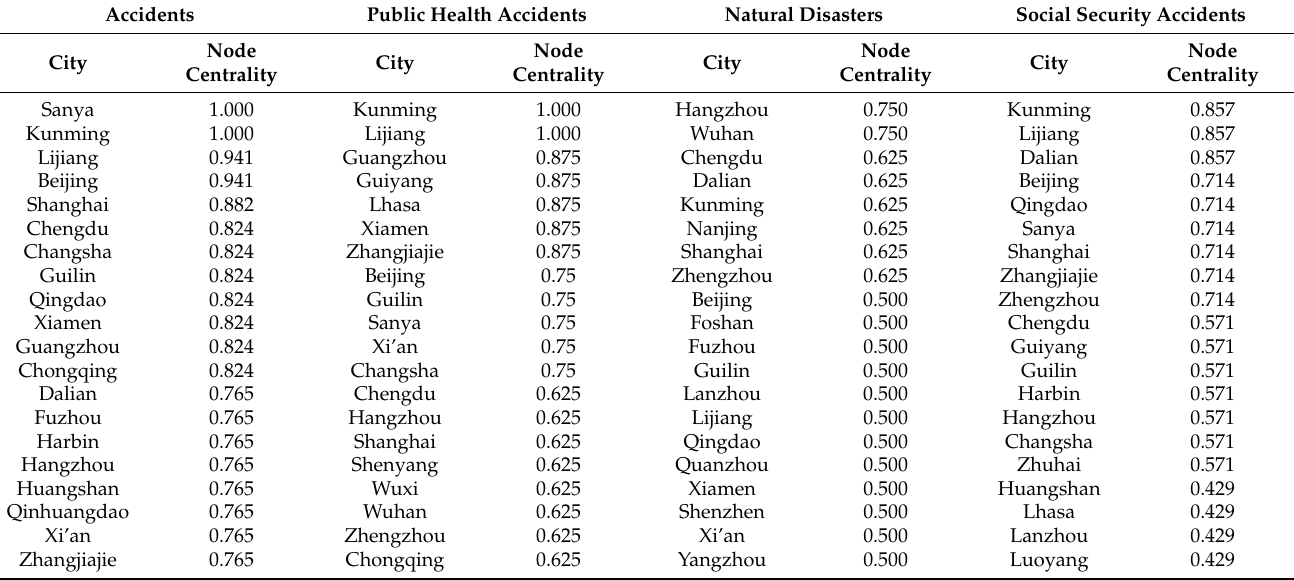
Table 2. Network centrality measurement of city-accident types.